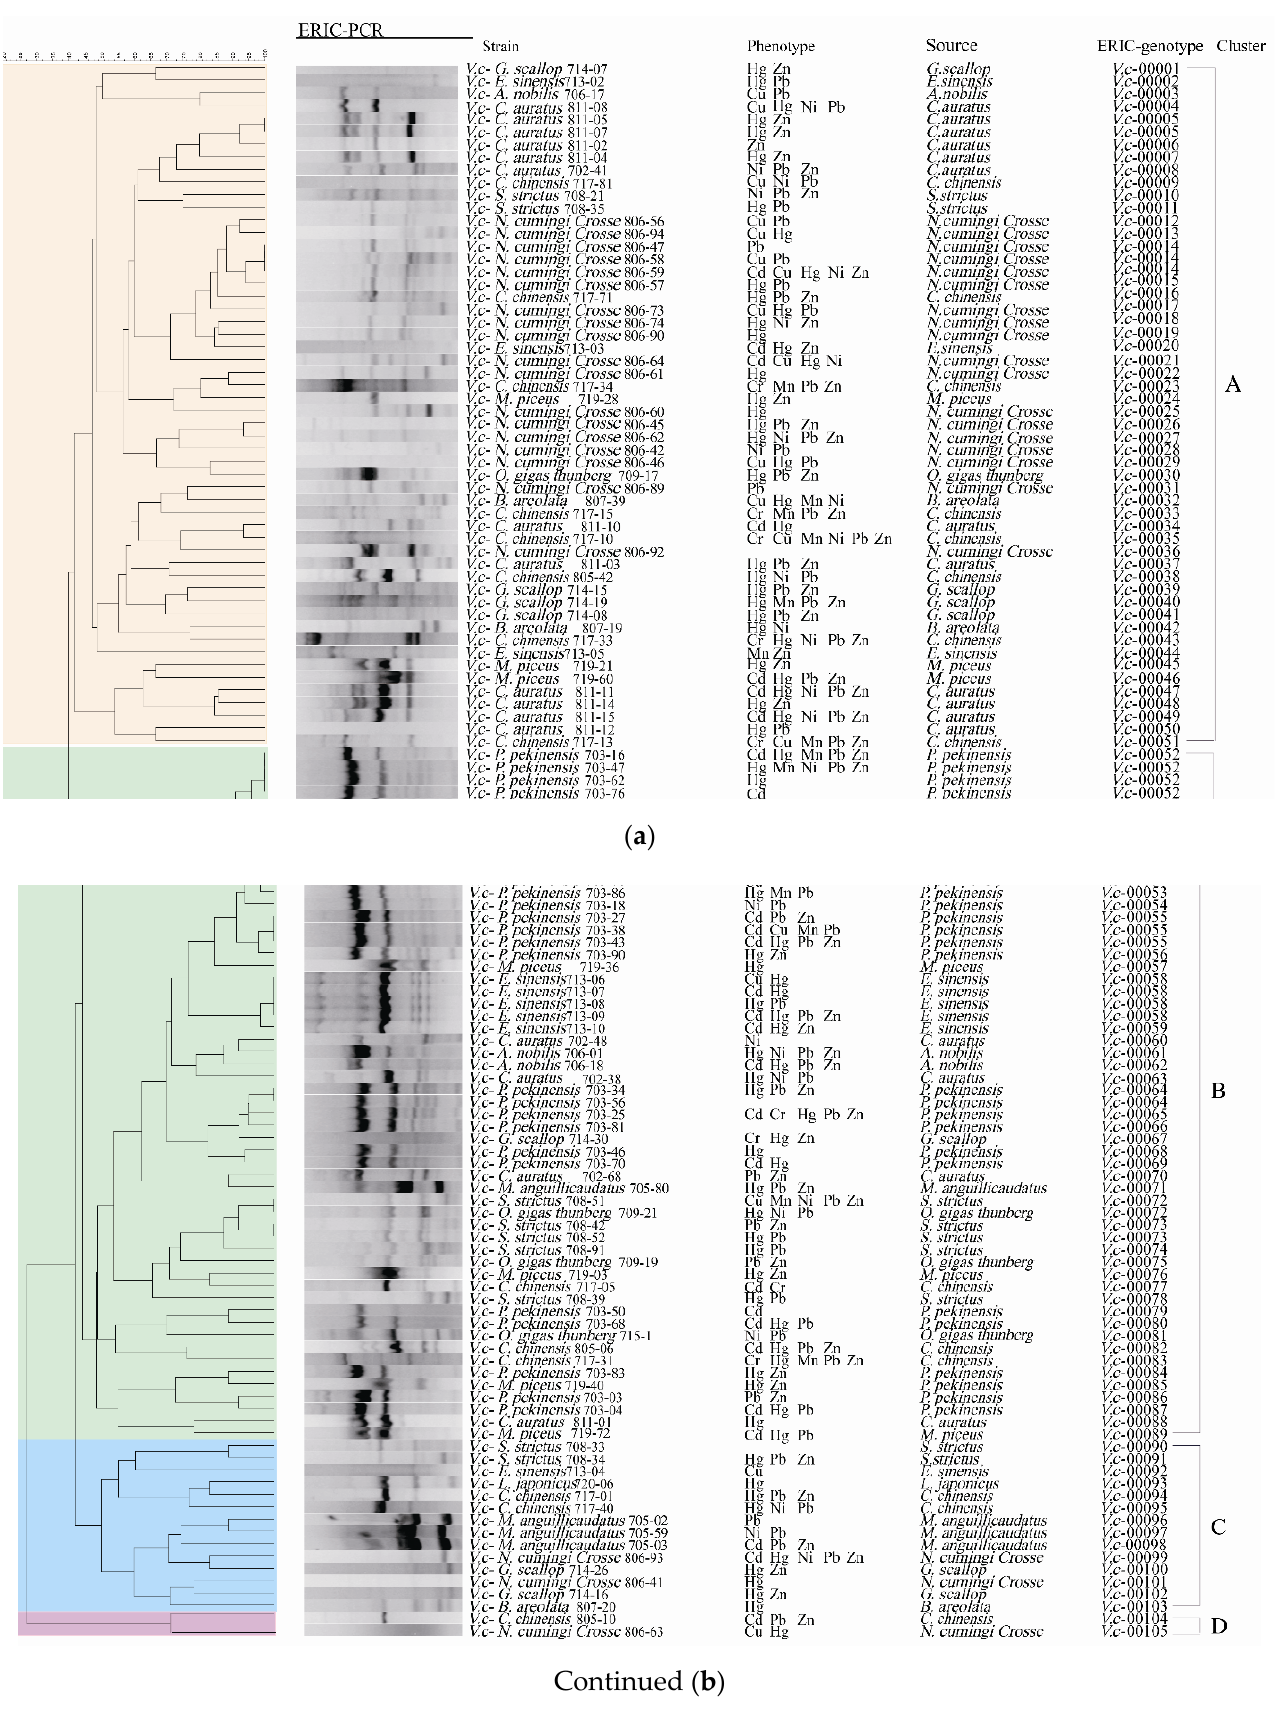
Figure 8. The ERIC-PCR fingerprinting profiles of the MDR V. cholerae isolates. ( a , b ): half of the profiles.